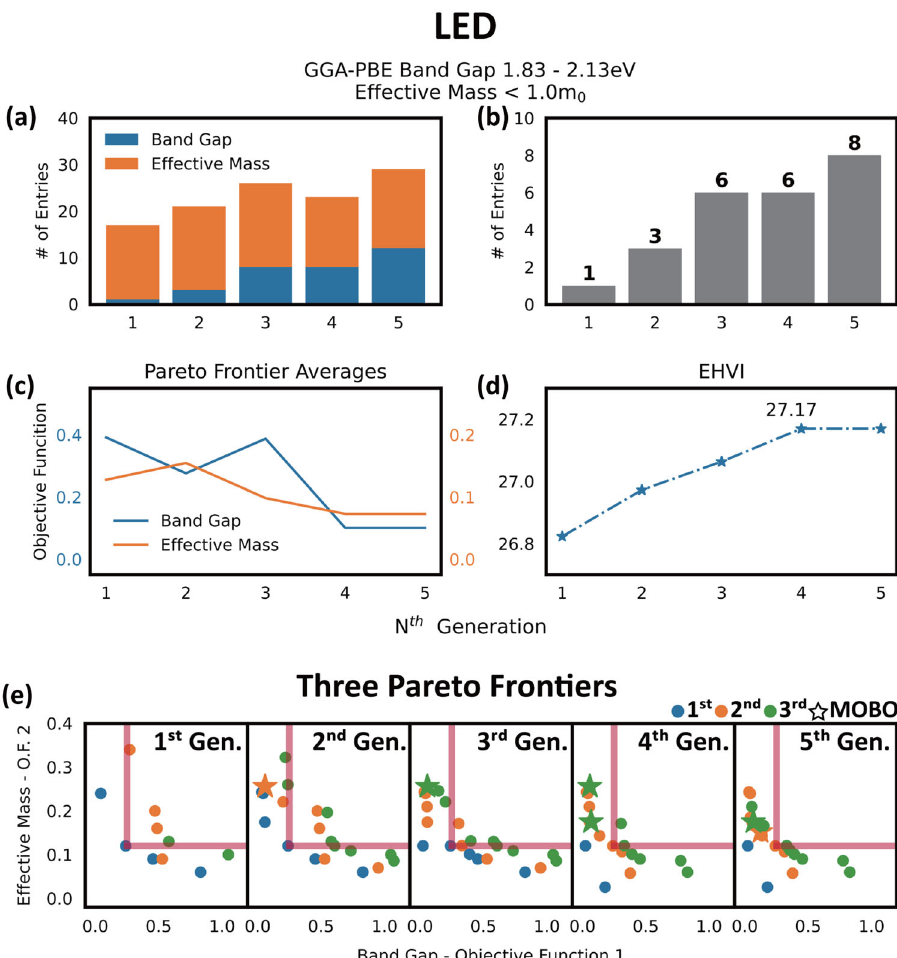
Fig. 3 The NSGA-II/MOBO screening result targeting HOIPs for LED applications. a The numbers of HOIP candidates exhibiting 1.83 < GGA_Eg < 2.13 eV and m e/h < m o . b The number of promising entries simultaneously ful fi lling the above conditions. c The band gap and effective mass objective functions averaged from the fi rst Pareto frontier are plotted as a function of the NSGA-II/MOBO round. Note that the band gap objective function does not represent the pristine band gap itself, and the effective mass objective function is the maximum effective mass out of electron and hole masses. d The EHVI is plotted as a function of the MOBO round. The increasing trend is indicative of a certain degree of intended evolution. e Pareto-sorted entries were collected from the top three Pareto frontiers of each generation for the NSGA-II/MOBO iteration (the MOBO-nominated entries are separately marked as